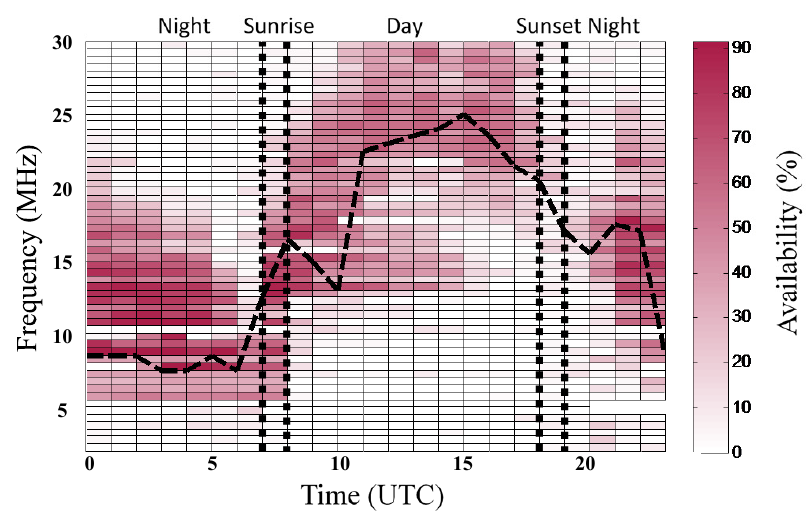
Figure 16. Channel availability of the campaign of 2014 measured during the austral summer, from 25 January to 18